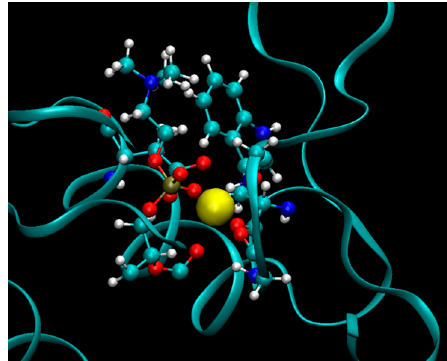
Figure 10. Bee venom PLA 2 binding pocket, demonstrating the binding of the PL-methotrexate complex. For clarity, only residues within 3.0 A of the Ca 2+ metal center are shown. The Ca 2+ ion is ligated to tryptophan, 2 glycine, and aspartate residues, as well as the phosphate group of the PL-methotrexate conjugate. Atoms are labeled as follows carbon (cyan), hydrogen (white), oxygen (red), nitrogen (blue), phosphate (gold), and calcium (yellow). The protein backbone is shown as a cyan ribbon.